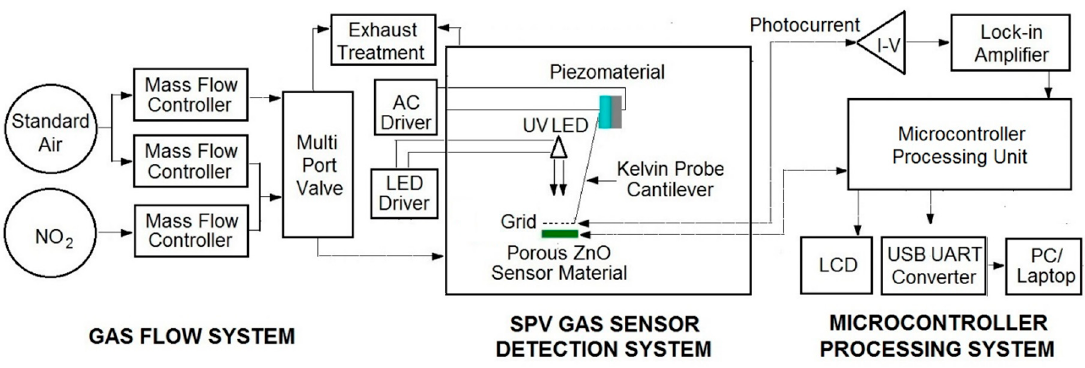
Figure 1. Simplified block-scheme of elaborated surface photovoltage (SPV) gas sensor system (device).